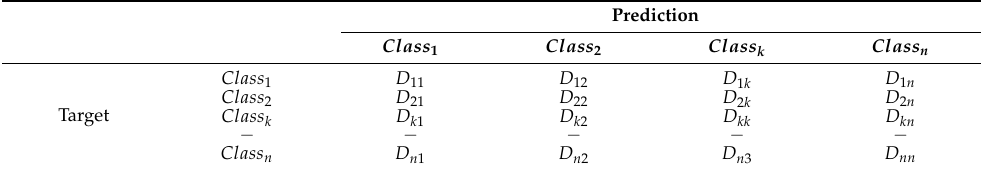
Table 3. Multi class Confusion matrix.